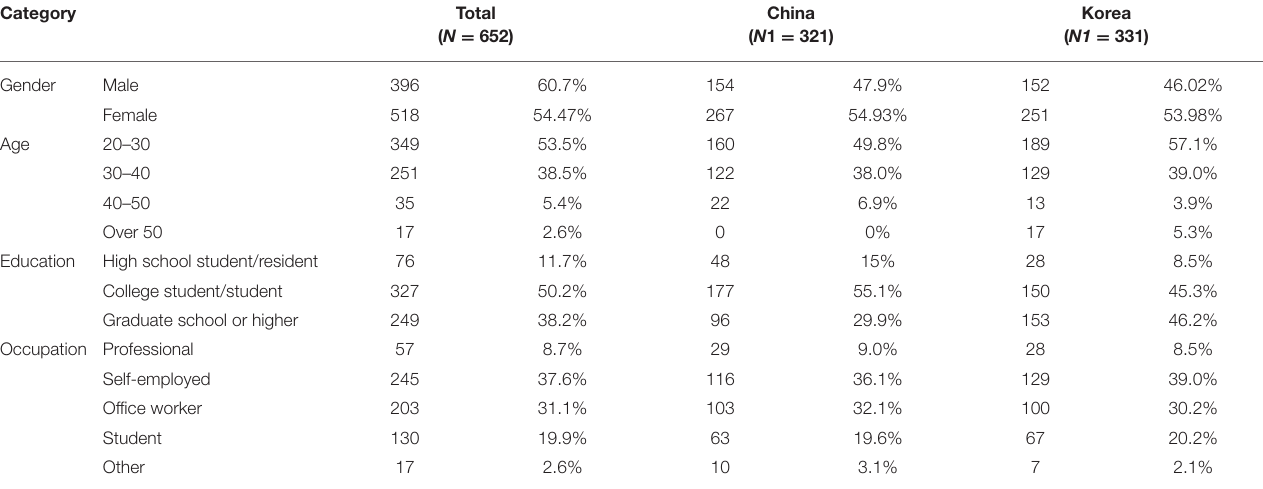
TABLE 1 | Sample structure.